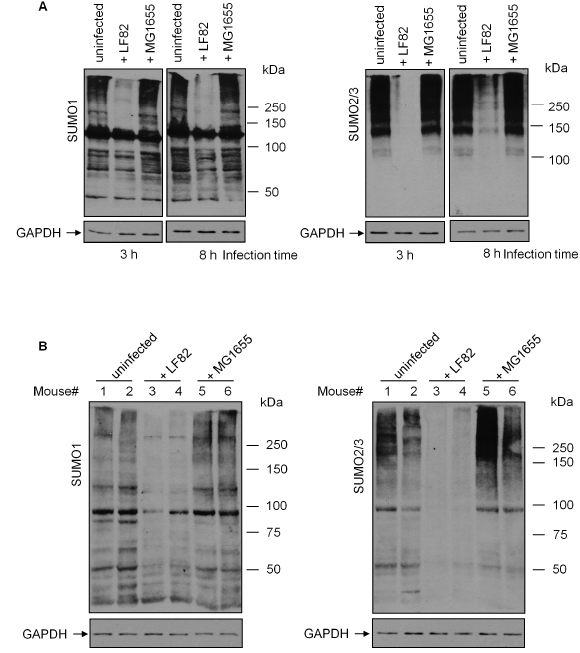
Figure 1. AIEC infection decreases SUMO-conjugated protein levels in intestinal epithelial T84 cells. ( A ) T84 cells were infected with the AIEC LF82 or the non-pathogenic E. coli MG1655 strain, and the SUMO-conjugated protein profiles were analyzed by Western blot. ( B ) CEABAC10 transgenic mice were infected with the LF82 or the MG1655 strain by gavage. After infection, the mice were sacrificed, and the ileal epithelial cells were isolated, as described in the Materials and Methods. SUMO-conjugated protein profiles of mouse enterocytes were analyzed by Western blot.